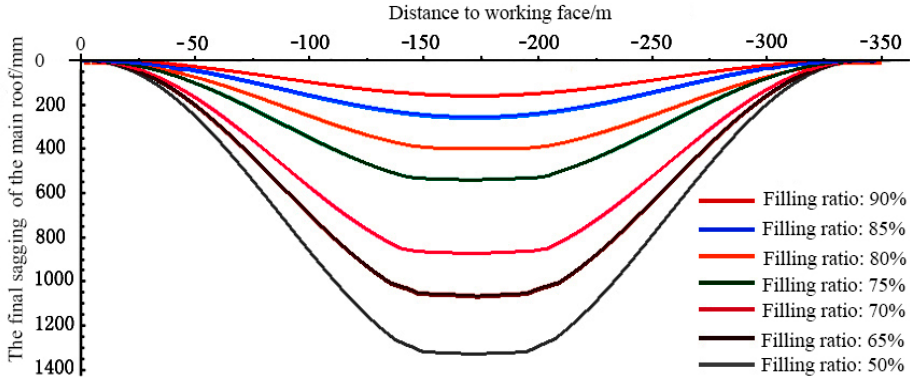
Figure 10. The final sagging curves of the main roof with different filling ratios.